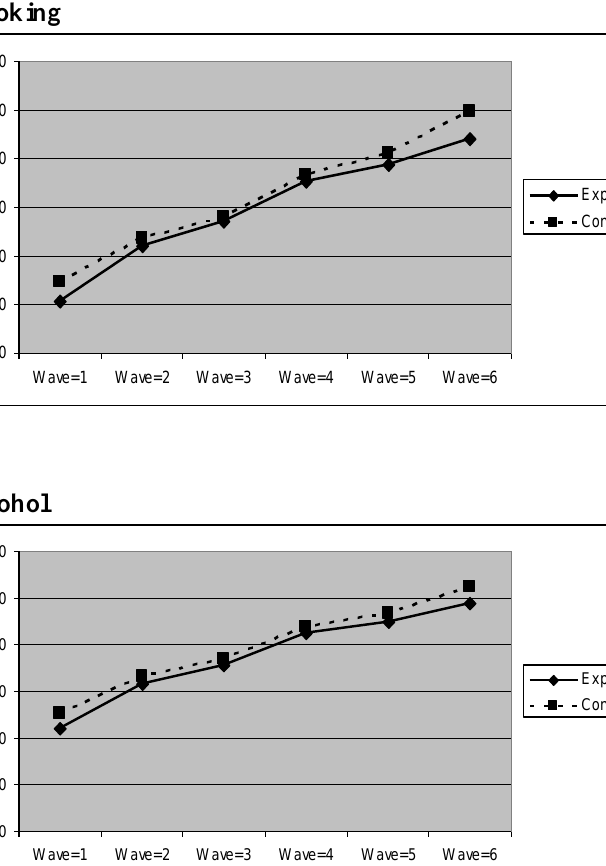
FIGURE 12 . Growth trajectories of the experimental group (Tier 1 participants who perceived the program as effective) and control group using the item score of ketamine use as the outcome